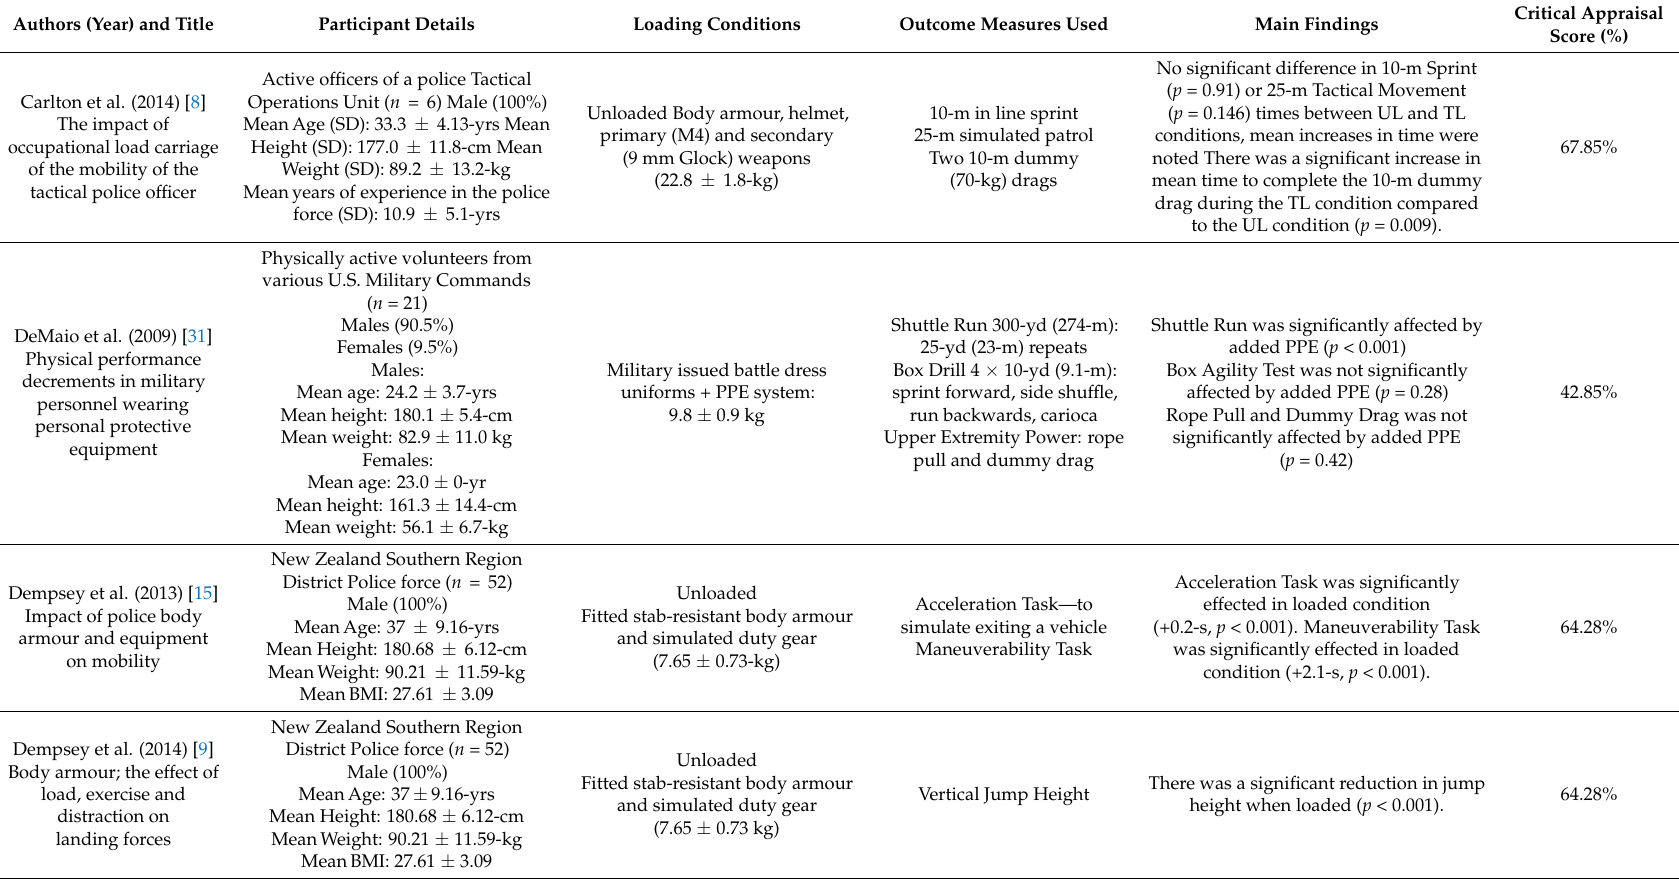
Table 3. Participants, loading conditions, outcome measures, and main